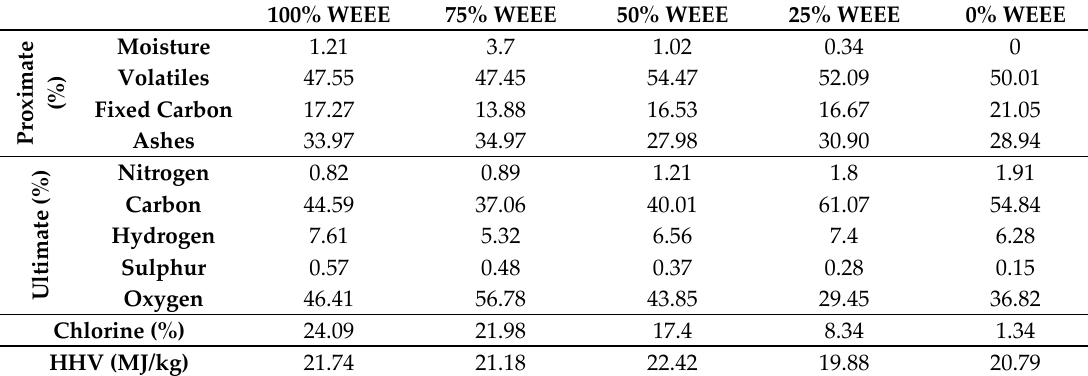
Table 2. Char characterization obtained from the carbonization